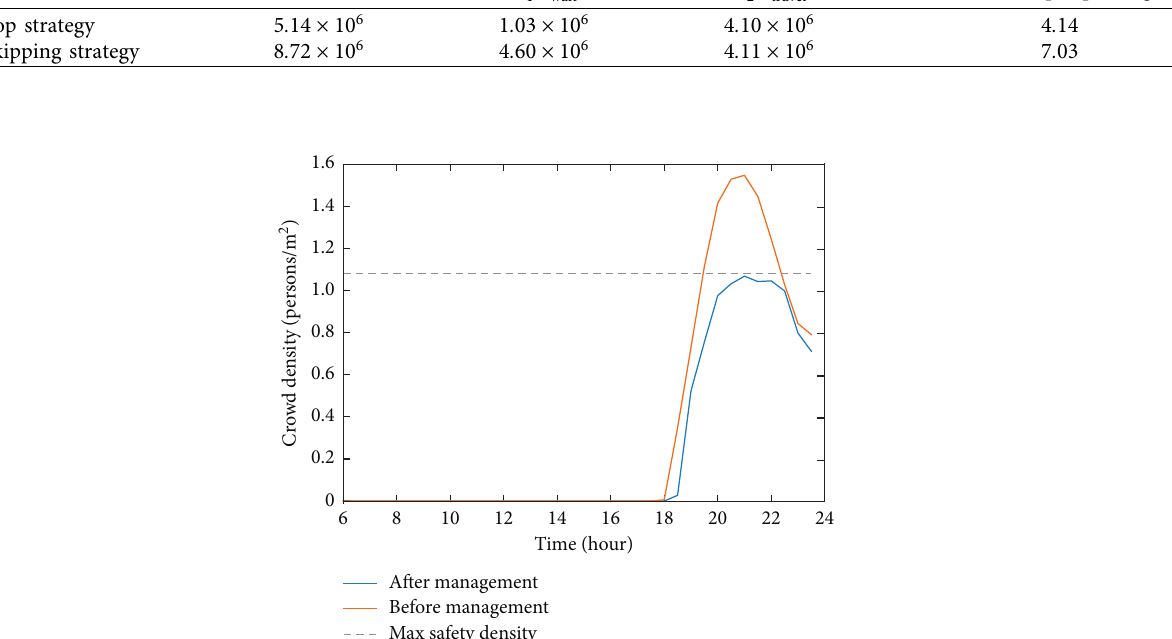
Figure 7: Crowd density is well controlled when implementing the stop-skipping management. The gray dotted line represents the maximum safe crowd density.